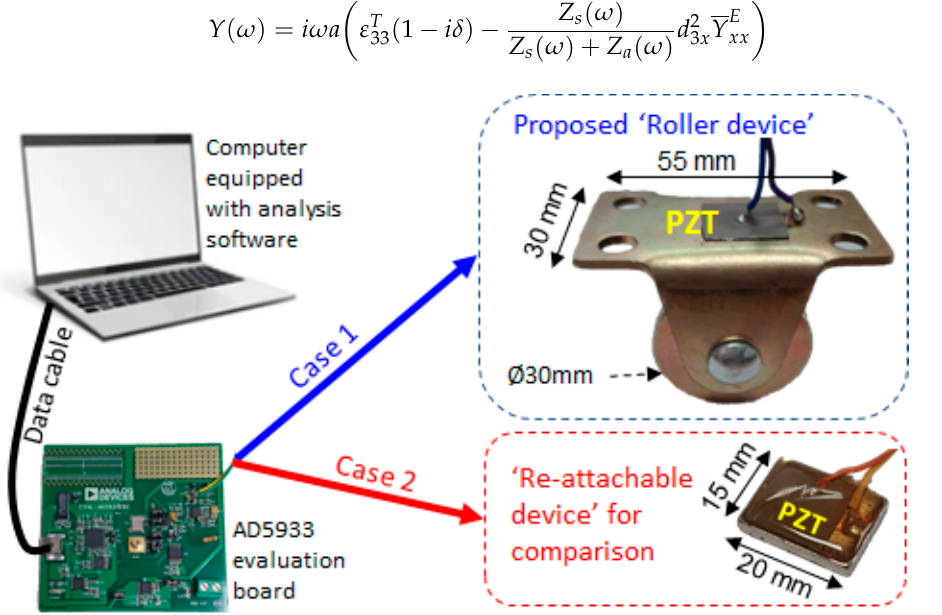
Figure 1. Photo of both temporary attachment devices with AD5933.